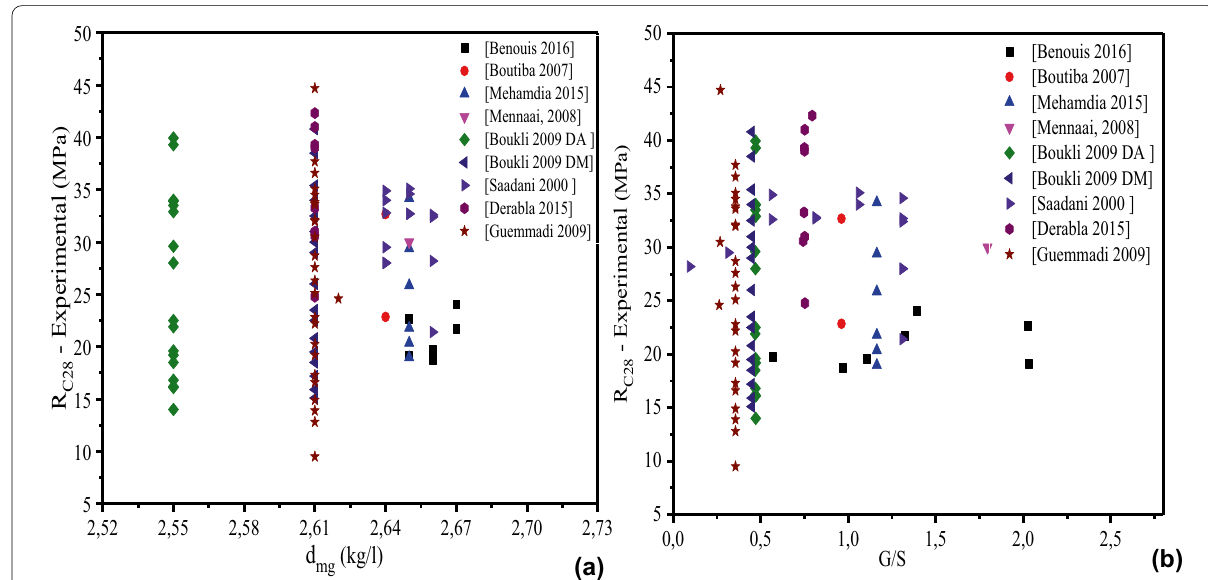
Fig. 6 Effect of the density d mg , G / S of the granular mixture on R C28 of concretes (all collected data). a Effect of the density d mg on R C28 of concretes, b effect of the ratio G / S on R C28 of